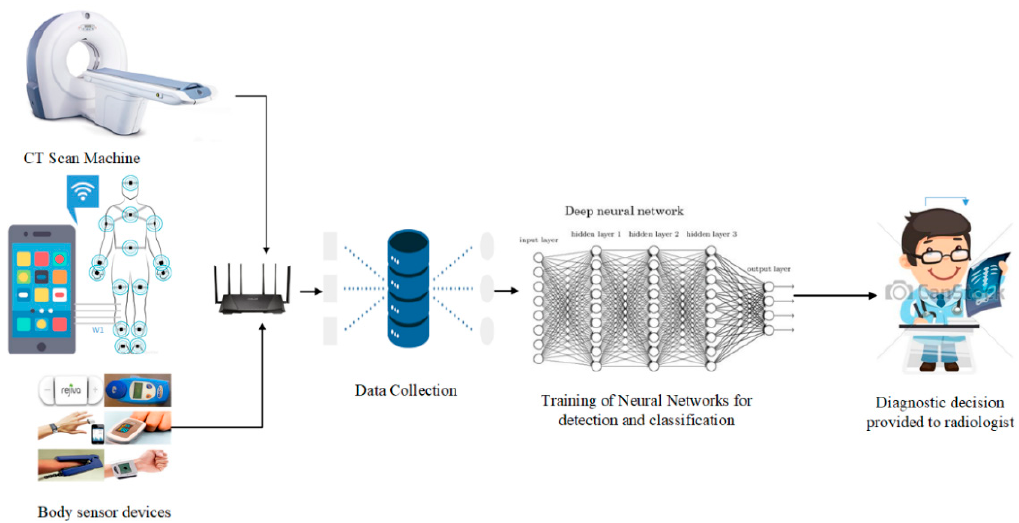
Figure 2. Overview structure of the proposed lung nodule detection and classification system.